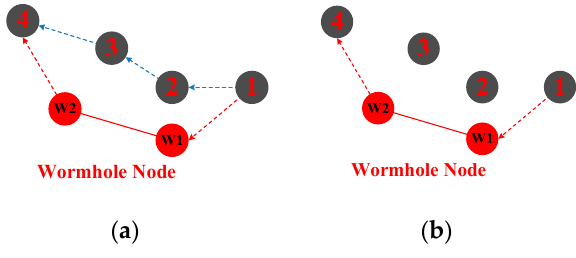
Figure 8. Wormhole attack; ( a ) normal route; ( b ) wormhole route.